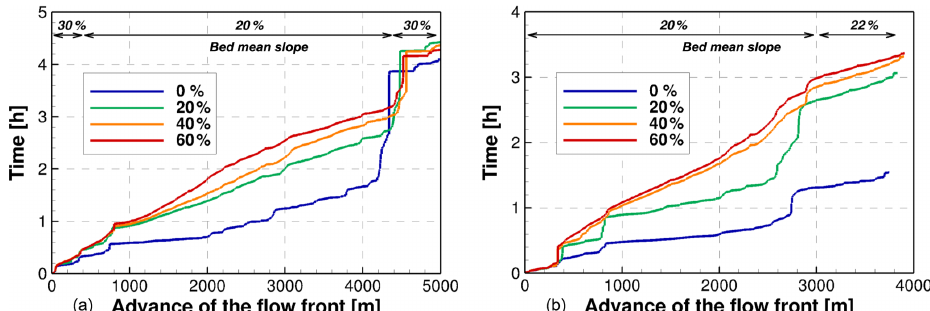
Figure 5. Location of the wave front in time for both streams, considering four different sediment concentrations, to characterize the advance of the flood in the river: (a) Quebrada de Ramón and (b) Quillayes streams.